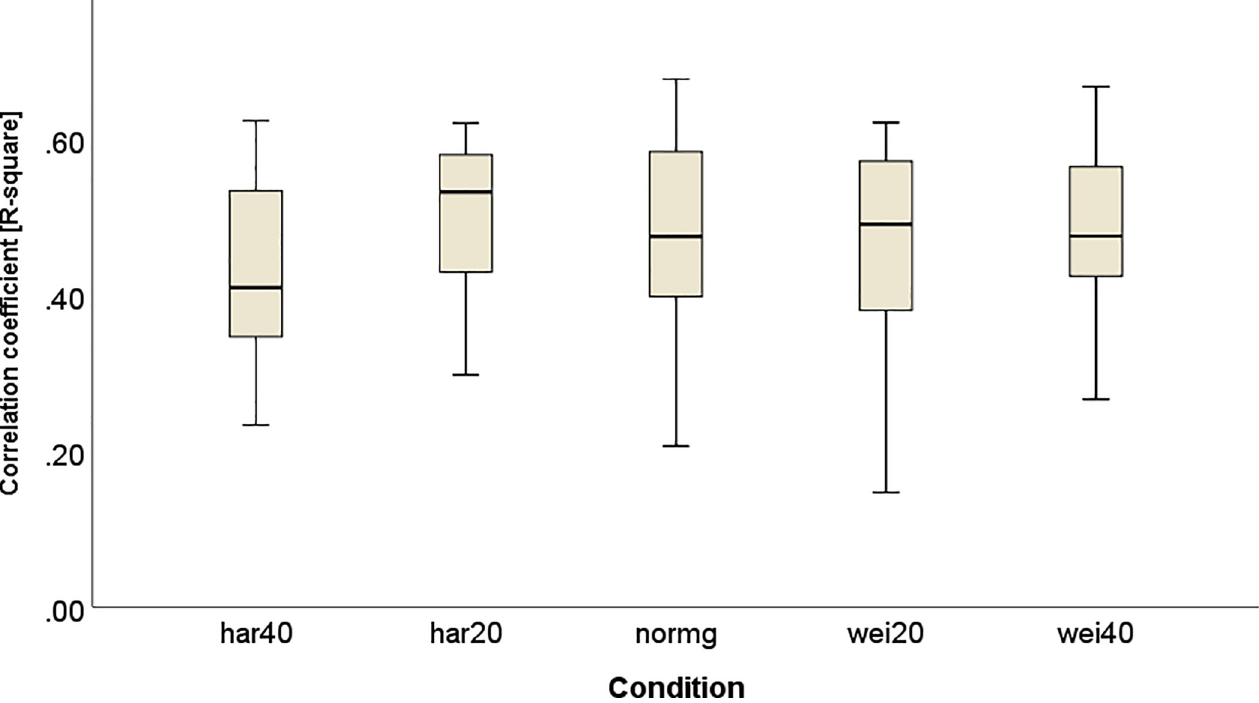
Fig 1. R 2 values from the multiple linear regression between footfall kinematics and XCoM in the iterative step specific analysis for each experimental condition.